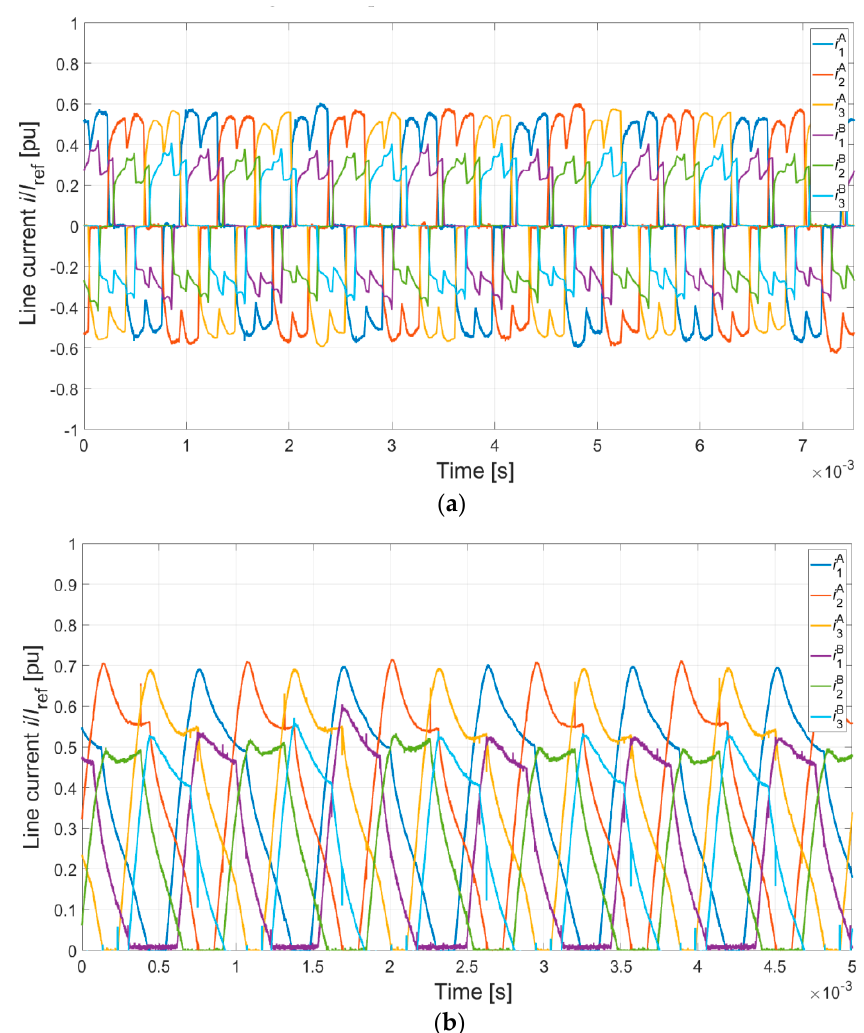
Figure 9. Relative electromagnetic torque and line currents in DCO mode for the DCBLDCM and the DCSRM at asymmetrical control. (a) Electromagnetic torque for the DCBLDCM. (b) Line currents for the DCBLDCM. (c ) Electromagnetic torque for the DCSRM. (d) Line currents for the DCSRM.